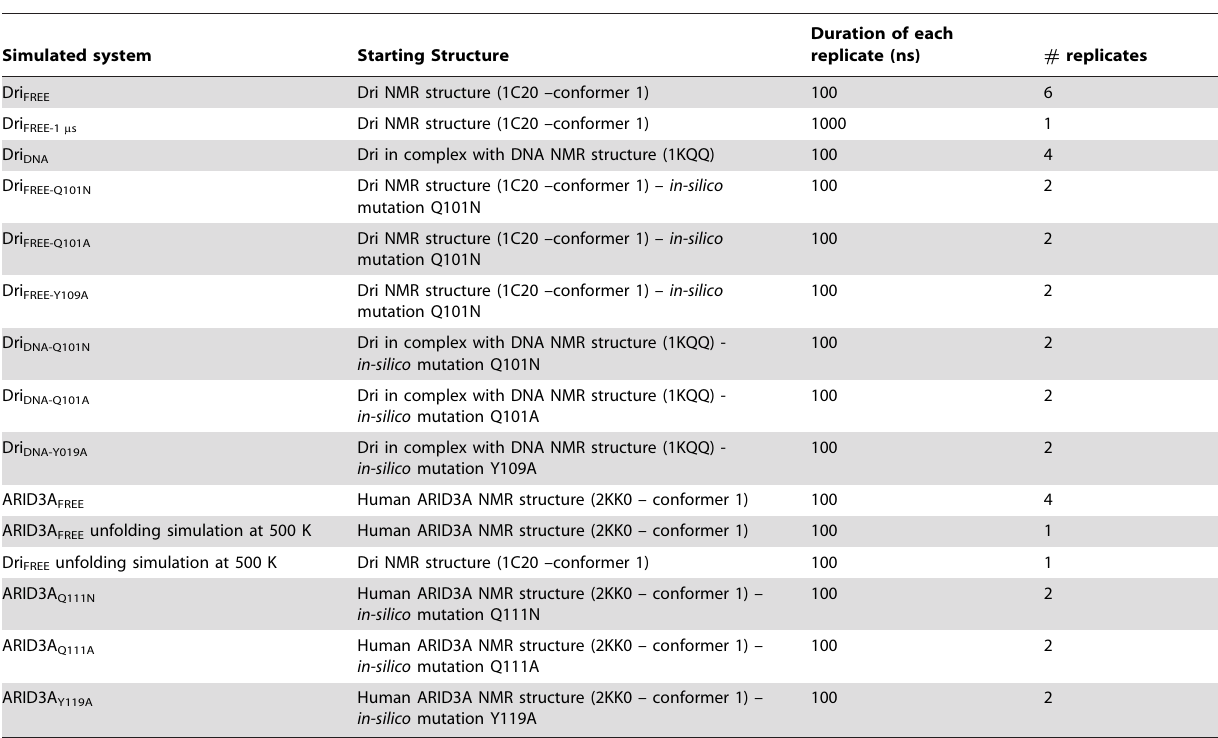
All the simulations were performed with CHARMM22* force field. doi:10.1371/journal.pcbi.1003744.t001 for Dri FREE-1 m s ( Figure S2 ). The one- m s trajectory has rmsd values comparable to the single 100-ns replicates ( Table 2 ). Further, the evolution of the chemical shift rmsd over the simulation time